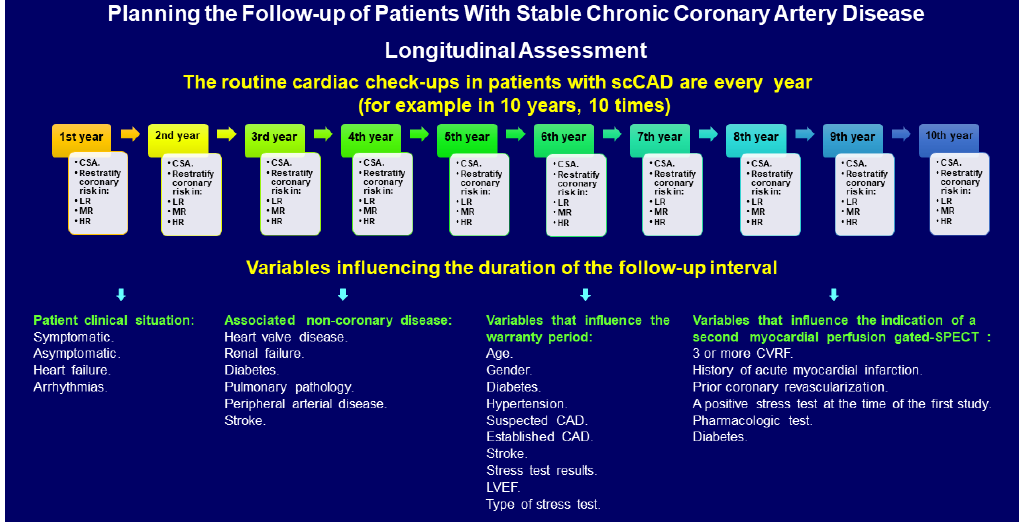
Figure 2. Longitudinal assessment algorithm. If we consider an annual cardiac check-up (Cch-up), as usual, the average number of Cch-ups during 10 years of follow-up is approximately 10. In this figure, many variables that can affect or determine the number of Cch-ups and/or the time intervals between Cch-ups are observed. Thus, the follow-up intervals vary according to the clinical situation of each patient. As clinicians, we know that there are patients who require check- ups every 6 months, or less (patients with MR or HR). Interval could be highly variable. If there is a possibility of ade- quately studying patients with imaging techniques, in order to be able to stratify them at different risk levels, this will help to plan the intervals during follow-up. CSA, cross-sectional assessment; LR, low risk, MR, moderate risk; HR, high risk.